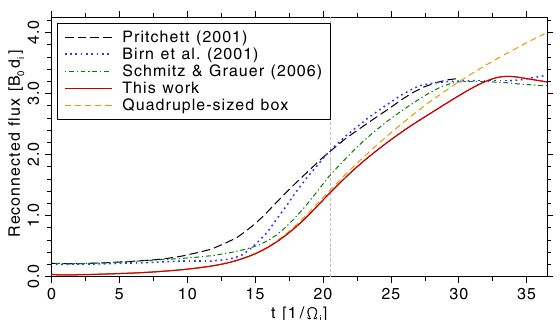
Figure 1. Evolution of the reconnected flux in our reference model, as well as for a quadruple-sized simulation domain, together with the data from Pritchett (2001), Birn et al. (2001), and Schmitz and Grauer (2006). The vertical gray dashed line indicates the time of the data snapshot we analyze in this